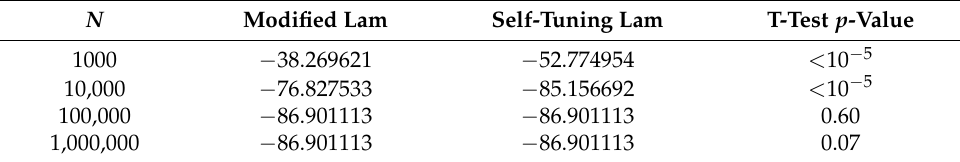
Table 17. Average solution for minimizing g 100 ( x ) . The minimum is g 100 ( x ) ≈ − 86.9011. N